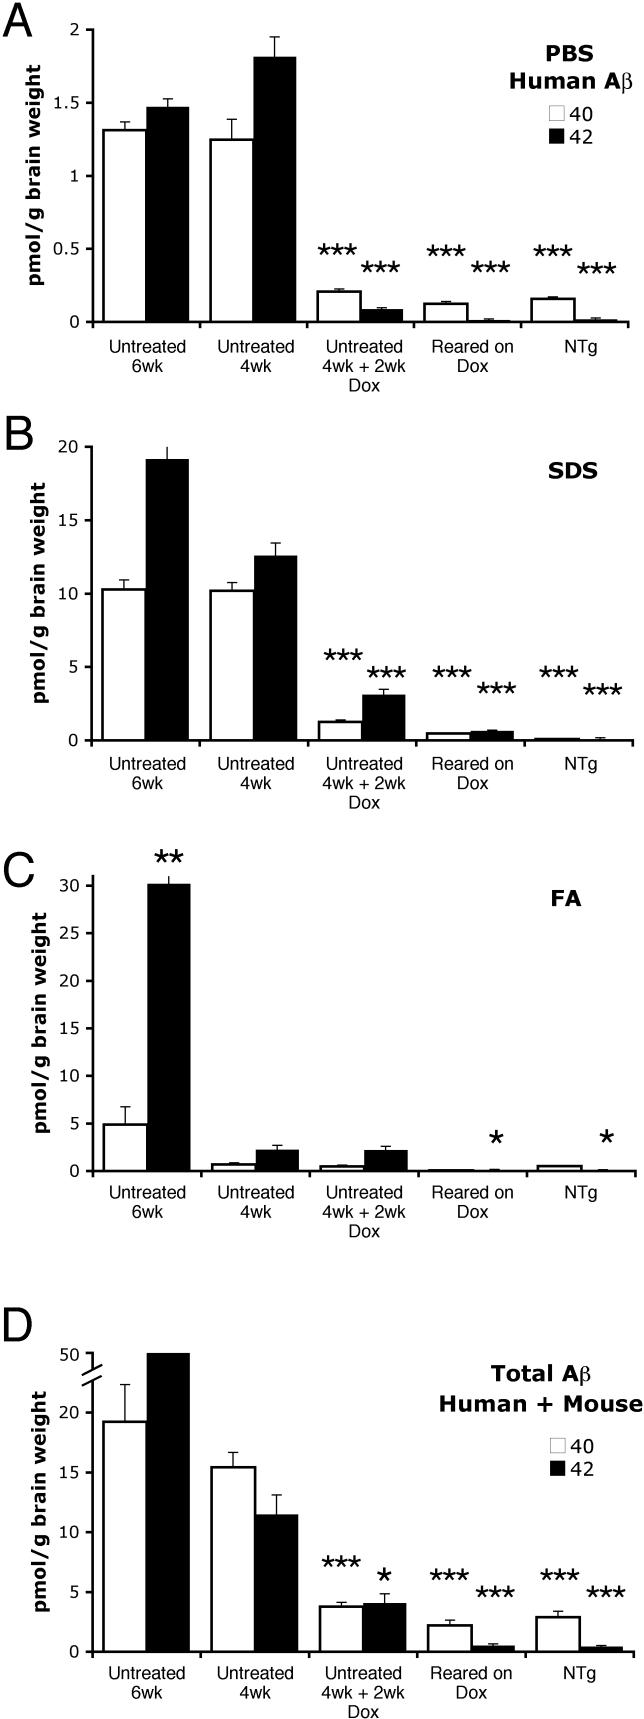
Aβ Levels Are Dramatically Reduced by Transgene SuppressionCortical homogenates from young, predeposit tTA/APP mice used for Western blot in Figure 1 (line 107) were fractionated by sequential multi-step extraction with PBS, 2% SDS, and 70% FA followed by human-specific Aβ ELISA to measure transgene-derived peptide in each fraction. Aβ40 is shown in white, Aβ42 in black.(A) PBS-soluble Aβ levels are substantially reduced by both acute and chronic dox treatment (ANOVA, effect of treatment group F
4,24 = 137.10 and 386.01, p < 0.001, for Aβ40 and Aβ42, respectively). Aβ levels in treated animals are indistinguishable from nontransgenic (NTg) animals (p > 0.3, Tukey post-hoc test).(B) In the young animals tested here prior to the formation of visible amyloid deposits, most Aβ is extracted into the SDS fraction (84% and 76% of all transgene-derived Aβ40 and Aβ42, respectively). As in the PBS-soluble fraction, Aβ levels in the SDS fraction are significantly lowered by dox treatment compared to untreated animals (ANOVA effect of group F
4,24 = 197.57 and 163.48, p < 0.001, for Aβ40 and Aβ42, respectively). Acutely treated animals retained a small (although significant) amount of residual peptide (p < 0.001 compared to nontransgeinc, Tukey post-hoc test), whereas Aβ levels in mice born and raised on dox were reduced to levels indistinguishable from nontransgenic (p > 0.8, Tukey post-hoc test).(C) The FA-soluble fraction already contains a small but significant pool of aggregated Aβ42 in untreated animals by 4 wk of age (p < 0.05 versus nontransgenic; Tukey post-hoc test applied to significant effect of group ANOVA F
4,24 = 17.11, p < 0.001). By 6 wk of age, the amount of Aβ in the FA fraction is increased significantly preceding the appearance of visible deposits 2 wk later. The FA pool is the only peptide fraction not lowered by acute dox treatment (4 wk untreated = 4 wk + 2 wk dox, p > 0.9, Tukey post-hoc test), consistent with poor turnover of aggregated Aβ species.(D) Measurements of total Aβ, including both endogenous and transgene-derived peptides, show that animals born and raised on dox harbor Aβ levels identical to nontransgenic animals (p > 0.9, Tukey post-hoc test, effect of group ANOVA F
4,24 = 39.13 and 35.29, p < 0.001, for Aβ40 and Aβ42, respectively). Whereas chronic transgene suppression fully prevents synthesis of both peptides, acute dox treatment fully suppresses Aβ40 levels (p > 0.8, Tukey post-hoc test), but leaves a small amount of nonsuppressed Aβ42. The residual Aβ42 observed in acutely treated young animals derives from uncleared aggregates extracted in the SDS and FA fractions. *, p < 0.05; **, p < 0.005; ***, p < 0.001 versus 4-wk-old untreated mice, Tukey post-hoc applied to significant effect of group ANOVA.